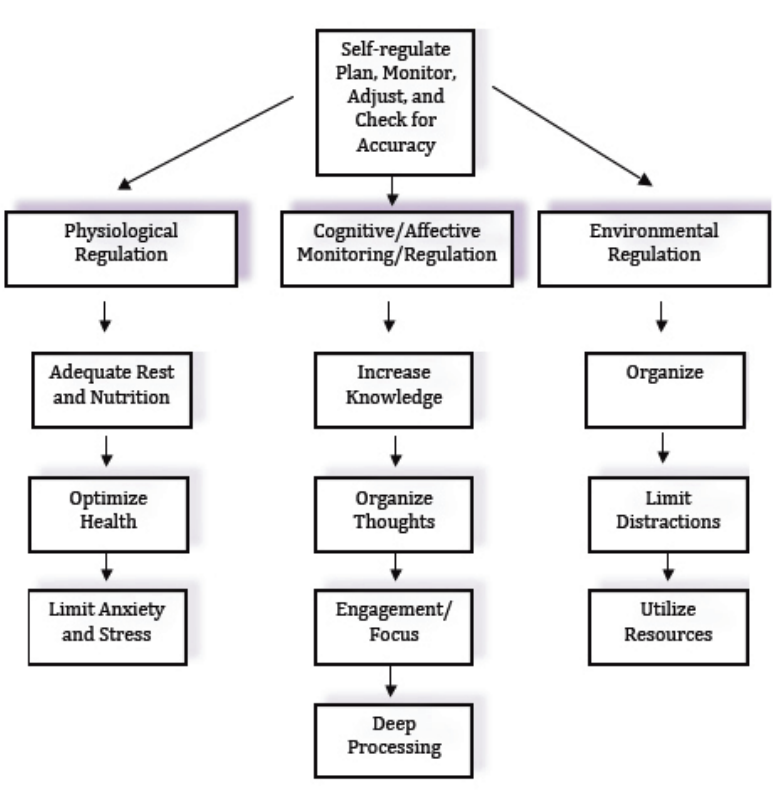
Figure 1. Model ofstrategies used to increase